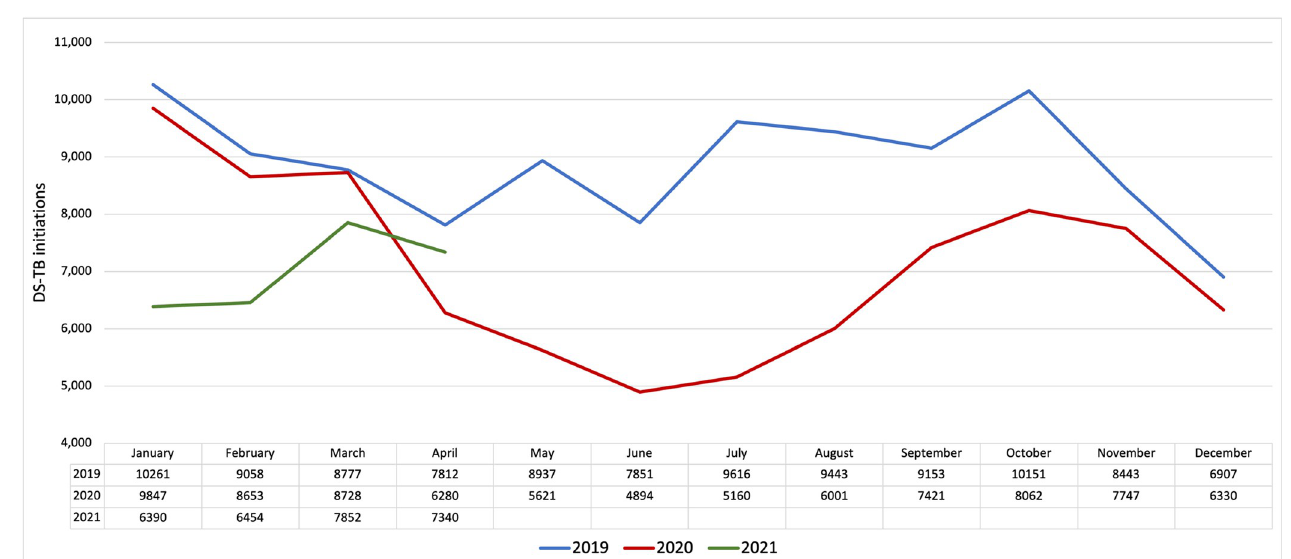
Fig 1. TB treatment initiations among facilities in limited dataset (N = 1,189), January 2019-April 2021.